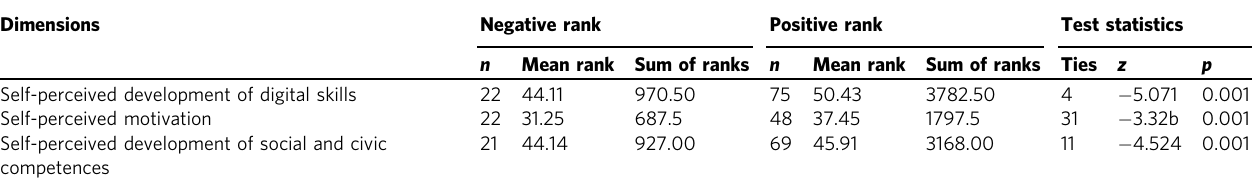
Table 4 Results of the Wilcoxon signed-rank test on the three dimensions of the questionnaire.